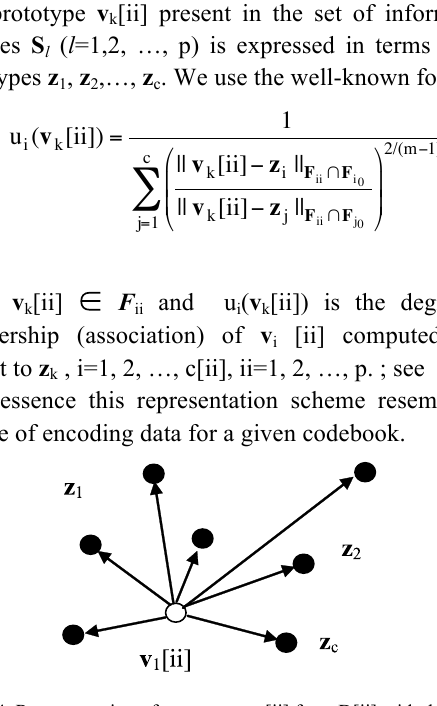
Figure 4. Representation of prototypes v i [ii] from D[ii] with the use of z 1 , z 2 , …, z c